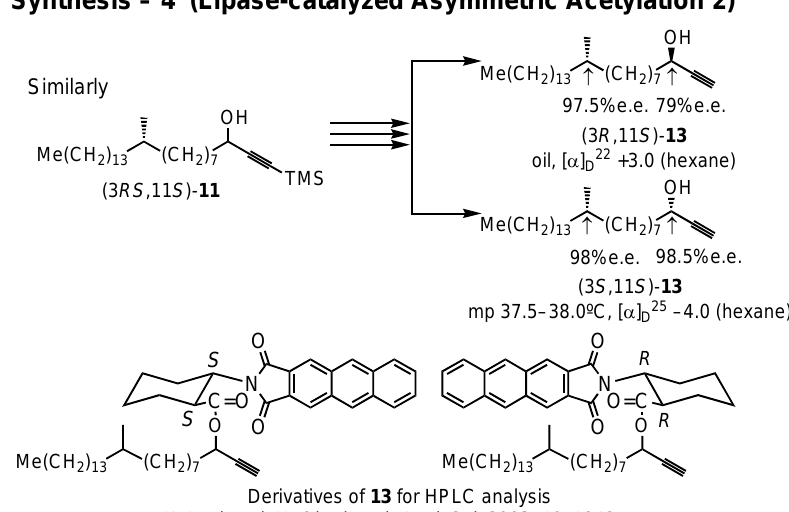
Synthesis – 4 (Lipase-catalyzed Asymmetric Acetylation